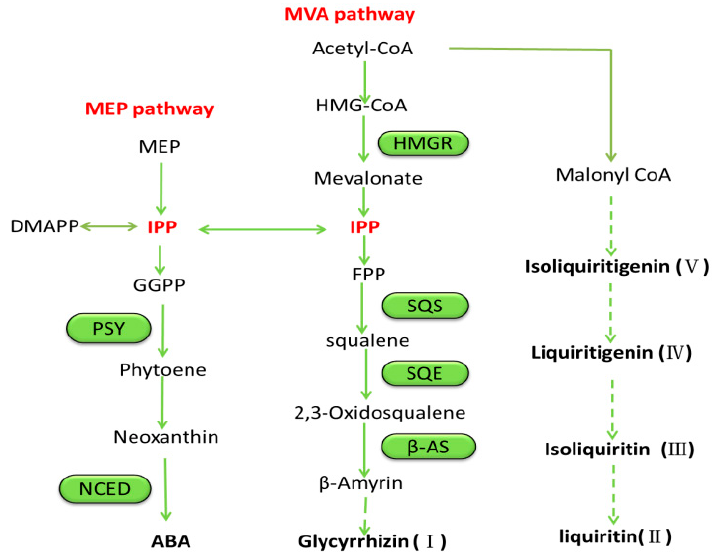
Figure 4. Biosynthesis pathway of ABA and five active components along with intermediates studied in this report. Biosynthesis of five active components via mevalonate (MVA) pathway, ABA biosynthesis via methylerythritol phosphate (MEP) pathway. HMG-CoA, 3-hydroxy-3-methyl glutaryl coenzyme A; DMAPP, dimethylallyl diphosphate; IPP, isopentenyl diphosphate; GGPP, geranylgeranyl pyrophosphate; FPP, farnesyl diphosphate; PSY, phytoene synthase; NCED, 9- cis -epoxycarotenoid dioxygenase; HMGR, HMG-CoA reductase; SQS, squalene synthase; SQE, squalene epoxidase; β -AS, beta-amyrin synthase.